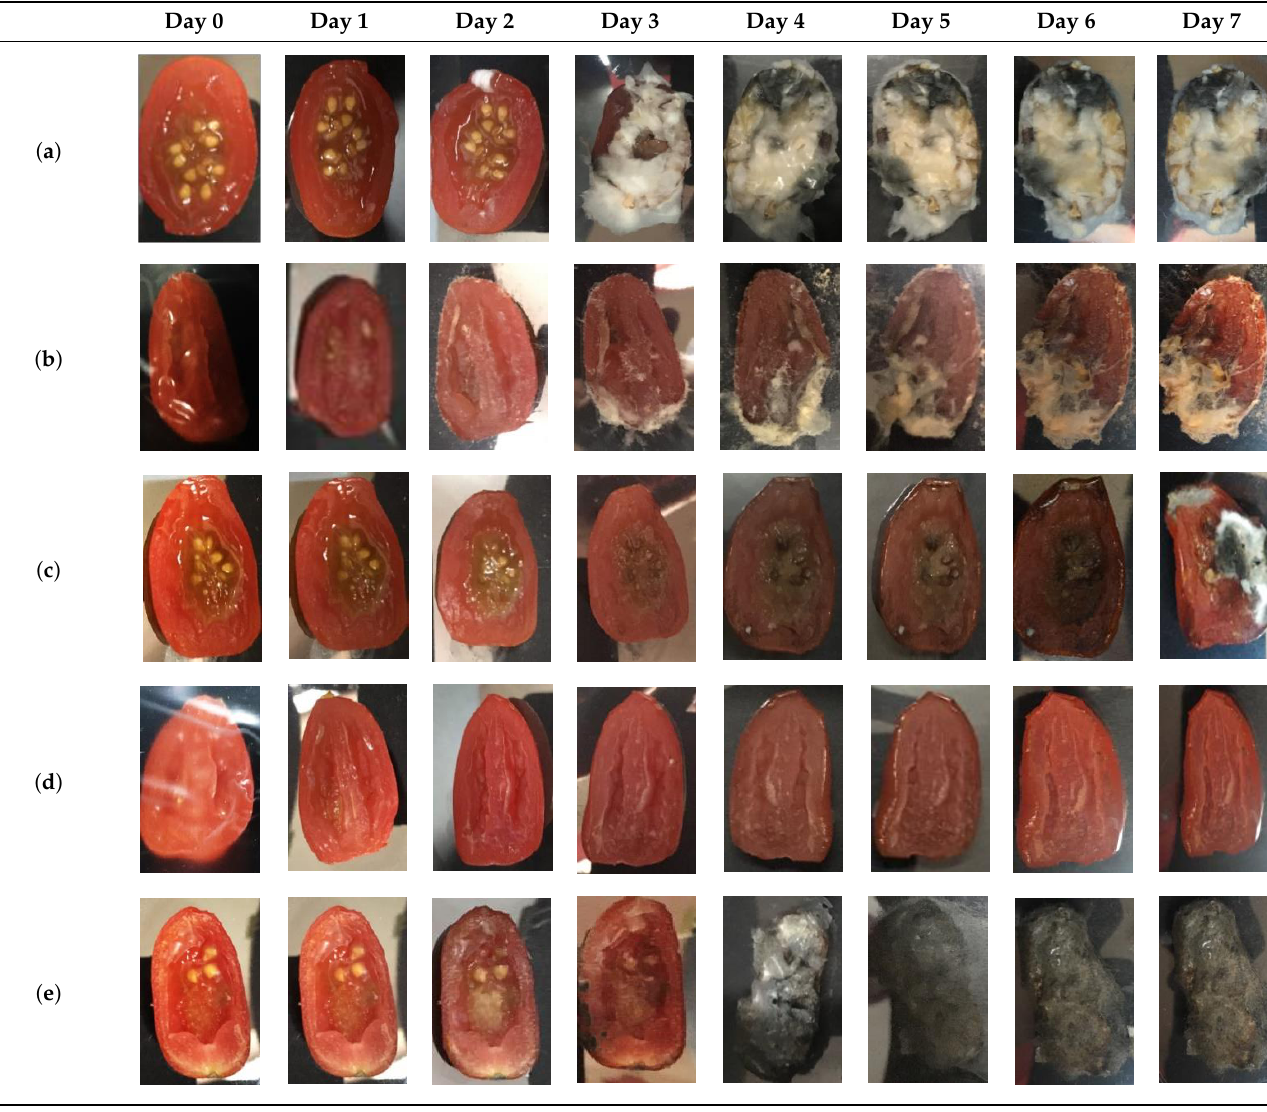
growth due to the tiny size of CNP that can inhibit microbial growth. Table 3. Appearance of sliced cherry tomatoes in direct contact with (a) neat CS film; (b) CS/CNP bio-nanocomposite film; Table 3. Appearance of sliced cherry tomatoes in direct contact with (a) neat CS film; (b) CS/CNP bio-nanocomposite film; Table 3. Appearance of sliced cherry tomatoes in direct contact with (a) neat CS film; (b) CS/CNP bio-nanocomposite film; Table 3. Appearance of sliced cherry tomatoes in direct contact with (a) neat CS film; (b) CS/CNP bio-nanocomposite film; Table 3. Appearance of sliced cherry tomatoes in direct contact with (a) neat CS film; (b) CS/CNP bio-nanocomposite film; Table 3. Appearance of sliced cherry tomatoes in direct contact with (a) neat CS film; (b) CS/CNP bio-nanocomposite film; Table 3. Appearance of sliced cherry tomatoes in direct contact with (a) neat CS film; (b) CS/CNP bio-nanocomposite film; Table 3. Appearance of sliced cherry tomatoes in direct contact with (a) neat CS film; (b) CS/CNP bio-nanocomposite film; Table 3. Appearance of sliced cherry tomatoes in direct contact with (a) neat CS film; (b) CS/CNP bio-nanocomposite film; Table 3. Appearance of sliced cherry tomatoes in direct contact with (a) neat CS film; (b) CS/CNP bio-nanocomposite film; Table 3. Appearance of sliced cherry tomatoes in direct contact with (a) neat CS film; (b) CS/CNP bio-nanocomposite film; Table 3. Appearance of sliced cherry tomatoes in direct contact with (a) neat CS film; (b) CS/CNP bio-nanocomposite film; Table 3. Appearance of sliced cherry tomatoes in direct contact with (a) neat CS film; (b) CS/CNP bio-nanocomposite film; Table 3. Appearance of sliced cherry tomatoes in direct contact with (a) neat CS film; (b) CS/CNP bio-nanocomposite film; Table 3. Appearance of sliced cherry tomatoes in direct contact with (a) neat CS film; (b) CS/CNP bio-nanocomposite film; Table 3. Appearance of sliced cherry tomatoes in direct contact with (a) neat CS film; (b) CS/CNP bio-nanocomposite film; (c) CS/CNP/Thy 1.5% bio-nanocomposite film; (d) CS/CNP/Thy 3% bio-nanocomposite film; (e) CS/CNP/Thy 4.5% bio- (c) CS/CNP/Thy 1.5% bio-nanocomposite film; (d) CS/CNP/Thy 3% bio-nanocomposite film; (e) CS/CNP/Thy 4.5% bio- (c) CS/CNP/Thy 1.5% bio-nanocomposite film; (d) CS/CNP/Thy 3% bio-nanocomposite film; (e) CS/CNP/Thy 4.5% bio- (c) CS/CNP/Thy 1.5% bio-nanocomposite film; (d) CS/CNP/Thy 3% bio-nanocomposite film; (e) CS/CNP/Thy 4.5% bio- (c) CS/CNP/Thy 1.5% bio-nanocomposite film; (d) CS/CNP/Thy 3% bio-nanocomposite film; (e) CS/CNP/Thy 4.5% bio- (c) CS/CNP/Thy 1.5% bio-nanocomposite film; (d) CS/CNP/Thy 3% bio-nanocomposite film; (e) CS/CNP/Thy 4.5% bio- (c) CS/CNP/Thy 1.5% bio-nanocomposite film; (d) CS/CNP/Thy 3% bio-nanocomposite film; (e) CS/CNP/Thy 4.5% bio- (c) CS/CNP/Thy 1.5% bio-nanocomposite film; (d) CS/CNP/Thy 3% bio-nanocomposite film; (e) CS/CNP/Thy 4.5% bio- Table 3. Appearance of sliced cherry tomatoes in direct contact with (a) neat CS film; (b) CS/CNP bio-nanocomposite film; Table 3. Appearance of sliced cherry tomatoes in direct contact with (a) neat CS film; (b) CS/CNP bio-nanocomposite film; Table 3. Appearance of sliced cherry tomatoes in direct contact with (a) neat CS film; (b) CS/CNP bio-nanocomposite film; Table 3. Appearance of sliced cherry tomatoes in direct contact with (a) neat CS film; (b) CS/CNP bio-nanocomposite film; Table 3. Appearance of sliced cherry tomatoes in direct contact with (a) neat CS film; (b) CS/CNP bio-nanocomposite film; Table 3. Appearance of sliced cherry tomatoes in direct contact with (a) neat CS film; (b) CS/CNP bio-nanocomposite film; Table 3. Appearance of sliced cherry tomatoes in direct contact with (a) neat CS film; (b) CS/CNP bio-nanocomposite film; Table 3. Appearance of sliced cherry tomatoes in direct contact with (a) neat CS film; (b) CS/CNP bio-nanocomposite film; (c) CS/CNP/Thy 1.5% bio-nanocomposite film; (d) CS/CNP/Thy 3% bio-nanocomposite film; (e) CS/CNP/Thy 4.5% bio- (c) CS/CNP/Thy 1.5% bio-nanocomposite film; (d) CS/CNP/Thy 3% bio-nanocomposite film; (e) CS/CNP/Thy 4.5% bio- (c) CS/CNP/Thy 1.5% bio-nanocomposite film; (d) CS/CNP/Thy 3% bio-nanocomposite film; (e) CS/CNP/Thy 4.5% bio- (c) CS/CNP/Thy 1.5% bio-nanocomposite film; (d) CS/CNP/Thy 3% bio-nanocomposite film; (e) CS/CNP/Thy 4.5% bio- (c) CS/CNP/Thy 1.5% bio-nanocomposite film; (d) CS/CNP/Thy 3% bio-nanocomposite film; (e) CS/CNP/Thy 4.5% bio- (c) CS/CNP/Thy 1.5% bio-nanocomposite film; (d) CS/CNP/Thy 3% bio-nanocomposite film; (e) CS/CNP/Thy 4.5% bio- (c) CS/CNP/Thy 1.5% bio-nanocomposite film; (d) CS/CNP/Thy 3% bio-nanocomposite film; (e) CS/CNP/Thy 4.5% bio- (c) CS/CNP/Thy 1.5% bio-nanocomposite film; (d) CS/CNP/Thy 3% bio-nanocomposite film; (e) CS/CNP/Thy 4.5% bio- nanocomposite film. nanocomposite film. nanocomposite film. nanocomposite film. nanocomposite film. nanocomposite Table 3. Appearance of sliced cherry tomatoes in direct contact with (a) neat CS film; (b) CS/CNP bio-nanocomposite film; Table 3. Appearance of sliced cherry tomatoes in direct contact with (a) neat CS film; (b) CS/CNP bio-nanocomposite film; Table 3. Appearance of sliced cherry tomatoes in direct contact with (a) neat CS film; (b) CS/CNP bio-nanocomposite film; Table 3. Appearance of sliced cherry tomatoes in direct contact with (a) neat CS film; (b) CS/CNP bio-nanocomposite film; Table 3. Appearance of sliced cherry tomatoes in direct contact with (a) neat CS film; (b) CS/CNP bio-nanocomposite film; Table 3. Appearance of sliced cherry tomatoes in direct contact with (a) neat CS film; (b) CS/CNP bio-nanocomposite nanocomposite film. Table 3. Appearance of sliced cherry tomatoes in direct contact with (a) neat CS film; (b) CS/CNP bio-nanocomposite film; Table 3. Appearance of sliced cherry tomatoes in direct contact with (a) neat CS film; (b) CS/CNP bio-nanocomposite film; nanocomposite film. Table 3. Appearance of sliced cherry tomatoes in direct contact with (a) neat CS film; (b) CS/CNP bio-nanocomposite film; (c) CS/CNP/Thy 1.5% bio-nanocomposite film; (d) CS/CNP/Thy 3% bio-nanocomposite film; (e) CS/CNP/Thy 4.5% bio- (c) CS/CNP/Thy 1.5% bio-nanocomposite film; (d) CS/CNP/Thy 3% bio-nanocomposite film; (e) CS/CNP/Thy 4.5% bio- (c) CS/CNP/Thy 1.5% bio-nanocomposite film; (d) CS/CNP/Thy 3% bio-nanocomposite film; (e) CS/CNP/Thy 4.5% bio- (c) CS/CNP/Thy 1.5% bio-nanocomposite film; (d) CS/CNP/Thy 3% bio-nanocomposite film; (e) CS/CNP/Thy 4.5% bio- (c) CS/CNP/Thy 1.5% bio-nanocomposite film; (d) CS/CNP/Thy 3% bio-nanocomposite film; (e) CS/CNP/Thy 4.5% bio- (c) CS/CNP/Thy 1.5% bio-nanocomposite film; (d) CS/CNP/Thy 3% bio-nanocomposite film; (e) CS/CNP/Thy 4.5% bio- (c) CS/CNP/Thy 1.5% bio-nanocomposite film; (d) CS/CNP/Thy 3% bio-nanocomposite film; (e) CS/CNP/Thy 4.5% bio- (c) CS/CNP/Thy 1.5% bio-nanocomposite film; (d) CS/CNP/Thy 3% bio-nanocomposite film; (e) CS/CNP/Thy 4.5% bio- nanocomposite film. nanocomposite film. nanocomposite film. nanocomposite film. nanocomposite film. nanocomposite film. nanocomposite film. nanocomposite film. (c) CS/CNP/Thy 1.5% bio-nanocomposite film; (d) CS/CNP/Thy 3% bio-nanocomposite film; (e) CS/CNP/Thy 4.5% bio- (c) CS/CNP/Thy 1.5% bio-nanocomposite film; (d) CS/CNP/Thy 3% bio-nanocomposite film; (e) CS/CNP/Thy 4.5% bio- (c) CS/CNP/Thy 1.5% bio-nanocomposite film; (d) CS/CNP/Thy 3% bio-nanocomposite film; (e) CS/CNP/Thy 4.5% bio- (c) CS/CNP/Thy 1.5% bio-nanocomposite film; (d) CS/CNP/Thy 3% bio-nanocomposite film; (e) CS/CNP/Thy 4.5% bio- (c) CS/CNP/Thy 1.5% bio-nanocomposite film; (d) CS/CNP/Thy 3% bio-nanocomposite film; (e) CS/CNP/Thy 4.5% bio- (c) CS/CNP/Thy 1.5% bio-nanocomposite film; (d) CS/CNP/Thy 3% bio-nanocomposite film; (e) CS/CNP/Thy 4.5% bio- (c) CS/CNP/Thy 1.5% bio-nanocomposite film; (d) CS/CNP/Thy 3% bio-nanocomposite film; (e) CS/CNP/Thy 4.5% bio- (c) CS/CNP/Thy 1.5% bio-nanocomposite film; (d) CS/CNP/Thy 3% bio-nanocomposite film; (e) CS/CNP/Thy 4.5% bio- nanocomposite film. nanocomposite film. nanocomposite film. nanocomposite film. nanocomposite film. film; (c) CS/CNP/Thy 1.5% bio-nanocomposite film; (d) CS/CNP/Thy 3% bio-nanocomposite film; (e) CS/CNP/Thy 4.5% nanocomposite film. nanocomposite film. nanocomposite film. nanocomposite film. nanocomposite film. nanocomposite film. nanocomposite film. nanocomposite film. nanocomposite film. nanocomposite film. nanocomposite film. bio-nanocomposite film.